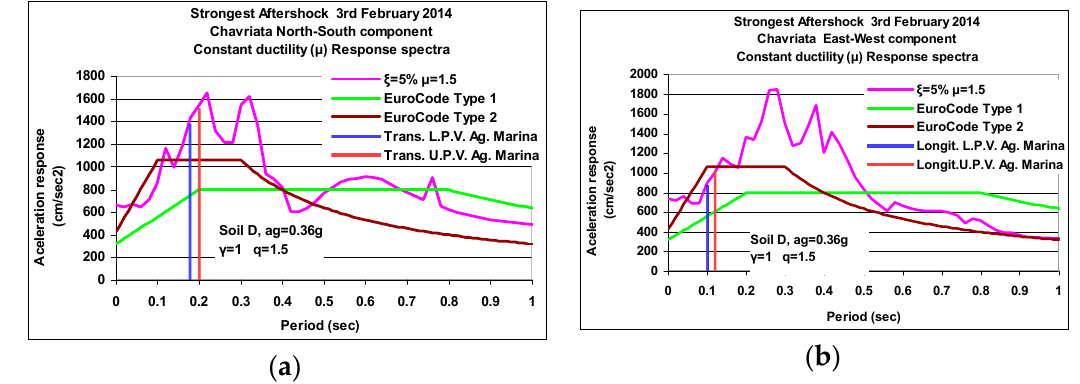
Figure 15. Constant ductility response spectral curves of the Chavriata record, Kefalonia 2014 earthquake together with the relevant Euro-Code 8 design spectral curves: ( a ) N-S component ( b ) E-W component.